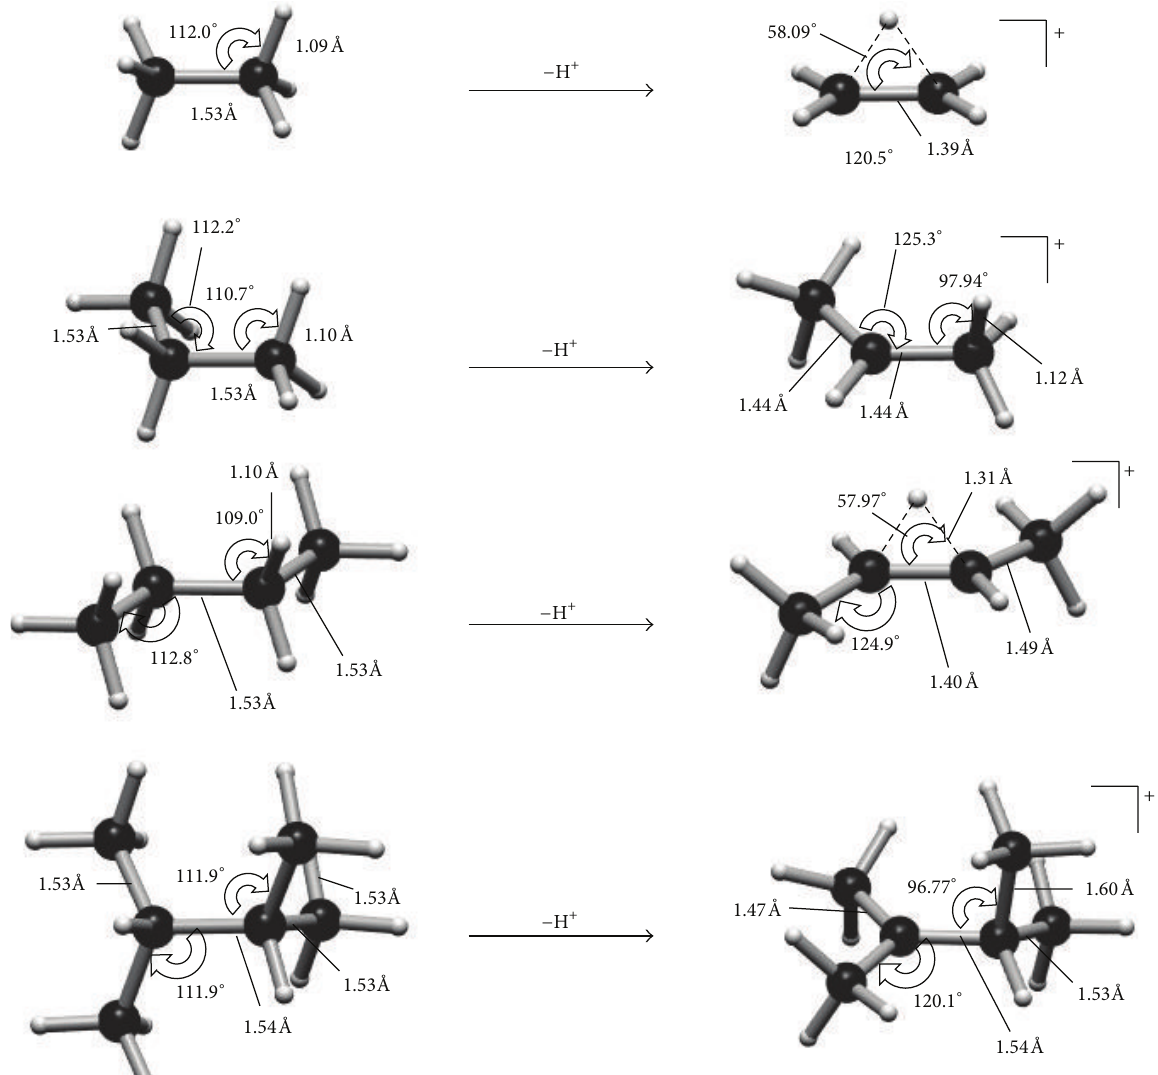
Figure 4: Structural comparisons between alkyl-substituted ethyl cations 1 , 3 , 5 , and 9 and their alkanes calculated by MP2/6-311+G(d,p) level of